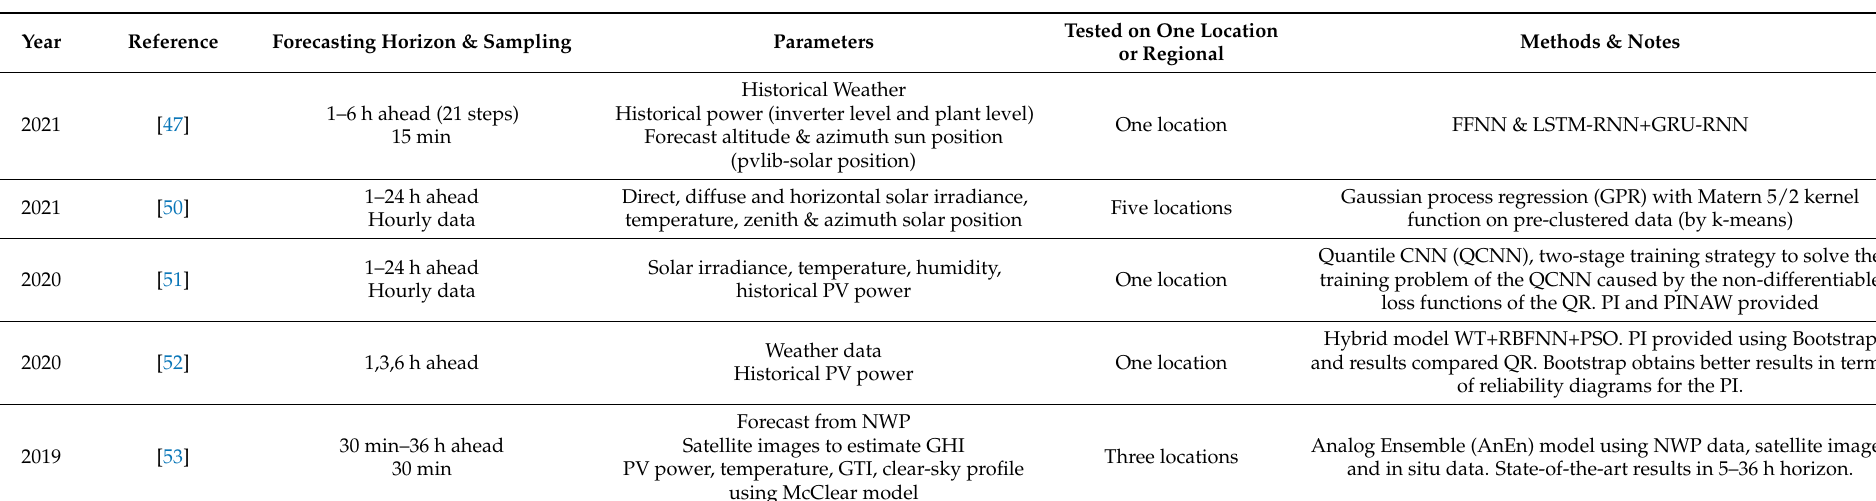
Table 3. Interval-forecast ML-based methods for PV power production. Publication year considered: